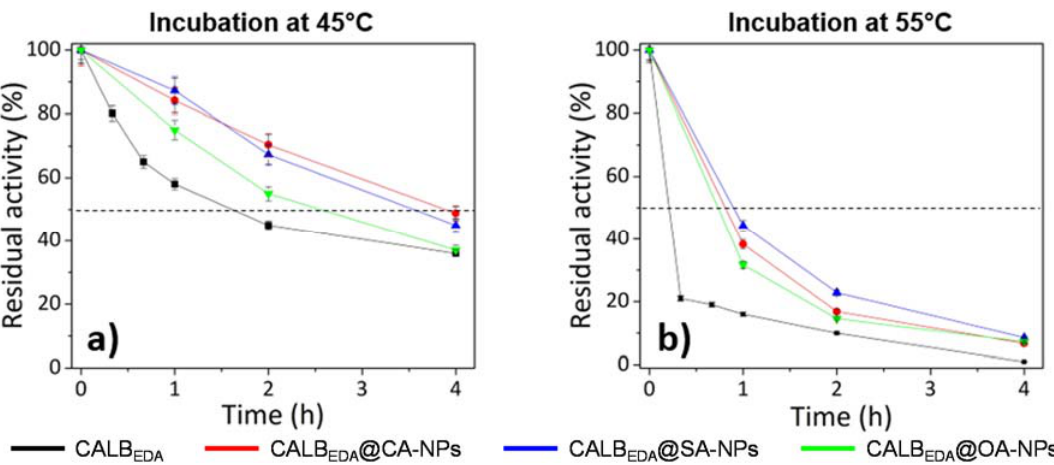
Figure 5. Thermal stability of free and immobilized CALB EDA at different temperatures: ( a ) 45 ◦ C and ( b ) 55 ◦ C.